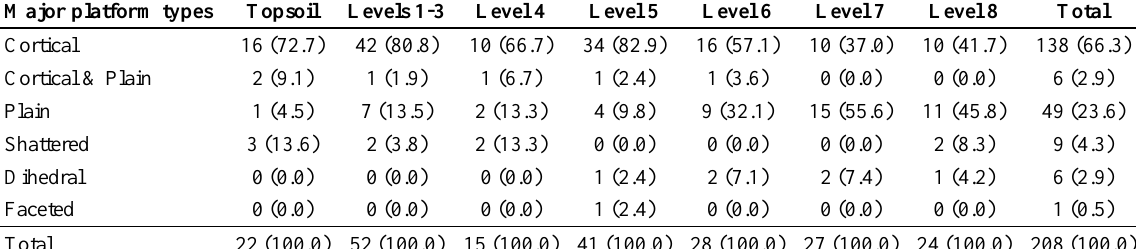
Table 4. Platform types for debitage products from Square 2 of Tell Ghanem